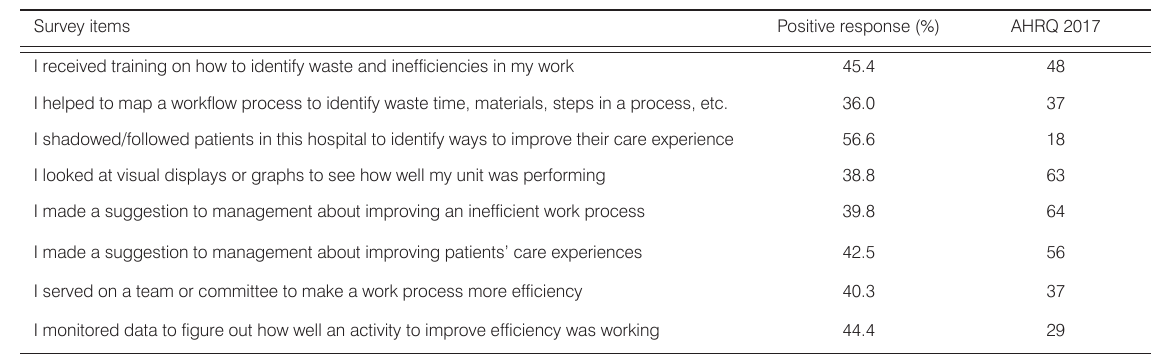
Table 2. Experience with activities to improve